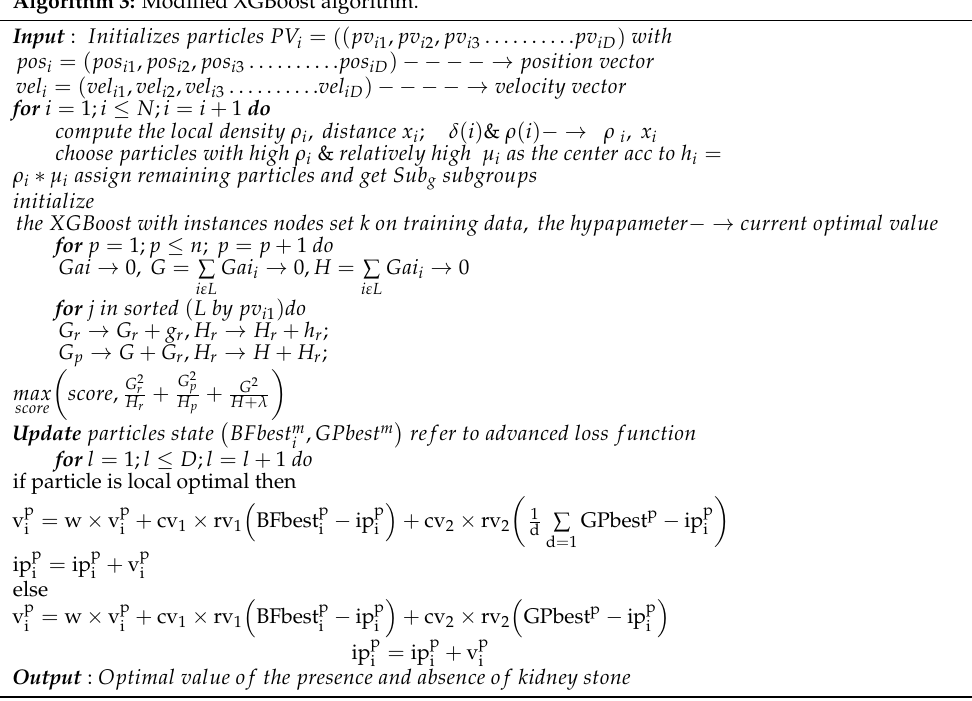
Algorithm 3: Modified XGBoost algorithm.